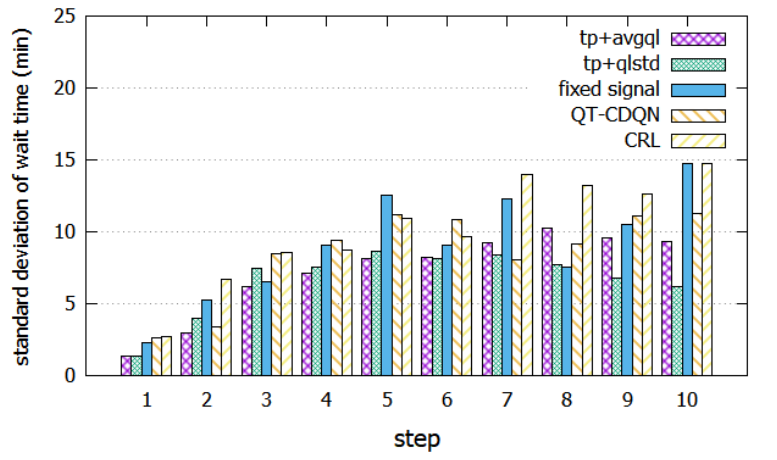
Figure 13. Performance comparison: standard deviation of wait